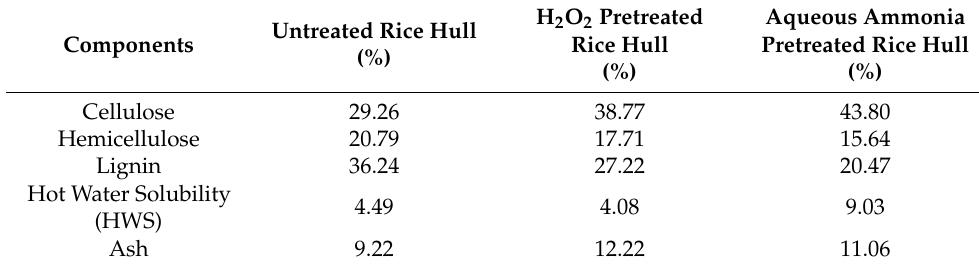
Table 1. The composition of rice husks before and after pre-treatment.